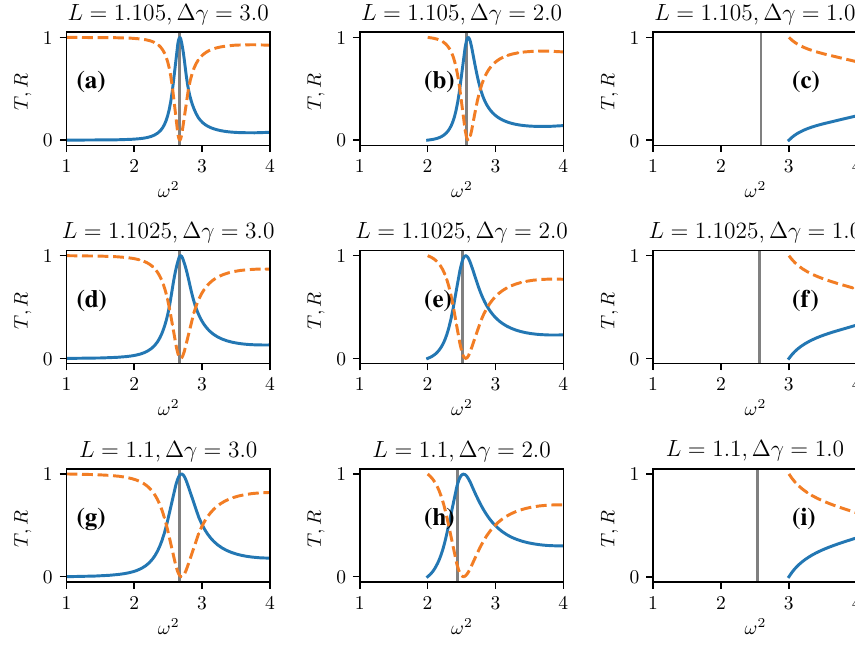
and reflection (dashed) coefficients as a function of the incident frequency for an incident wave in a barrier with a square well in the center. We vary (cid:8)γ and L and set γ = 4 . 0. Vertical grey lines are the QNM or bound state frequencies. The peaks are not exactly centered at the grey lines, but becomes more localized around it as L